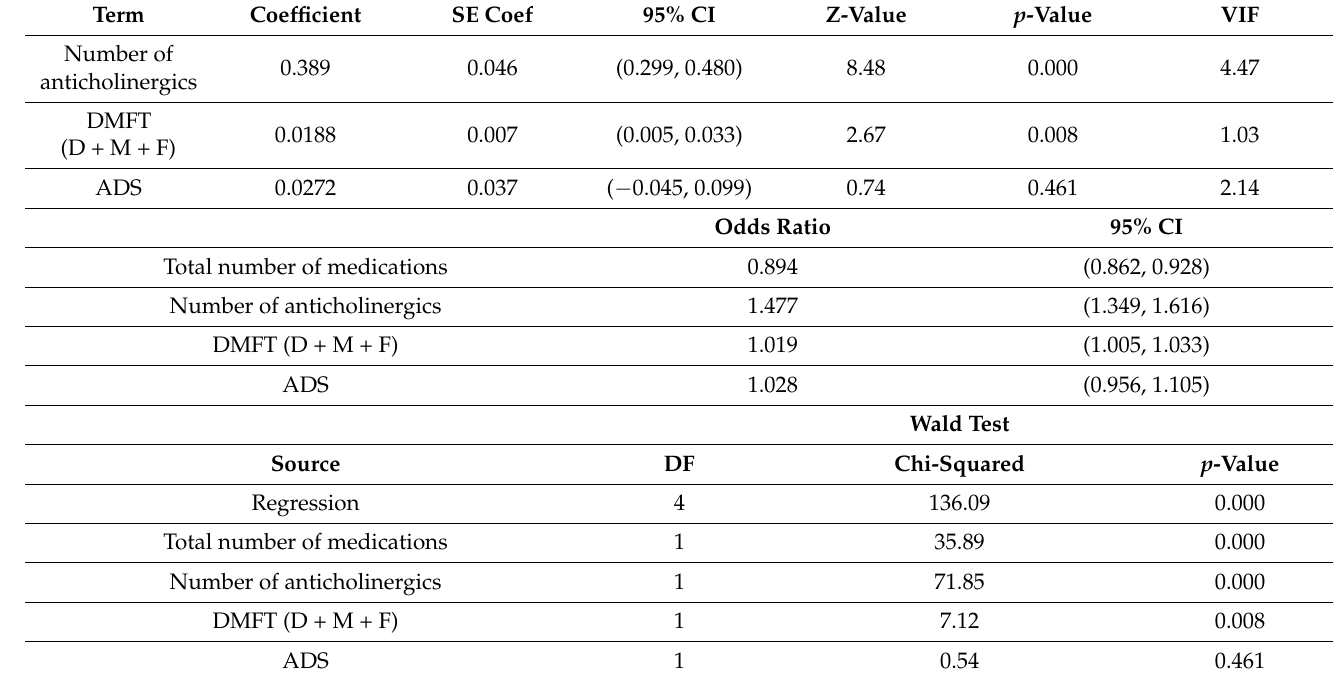
Table 3. Proportions of polypharmacy and anticholinergic polypharmacy. Comparison of observed frequencies in each age category was completed using the Chi-squared test ( p -value).